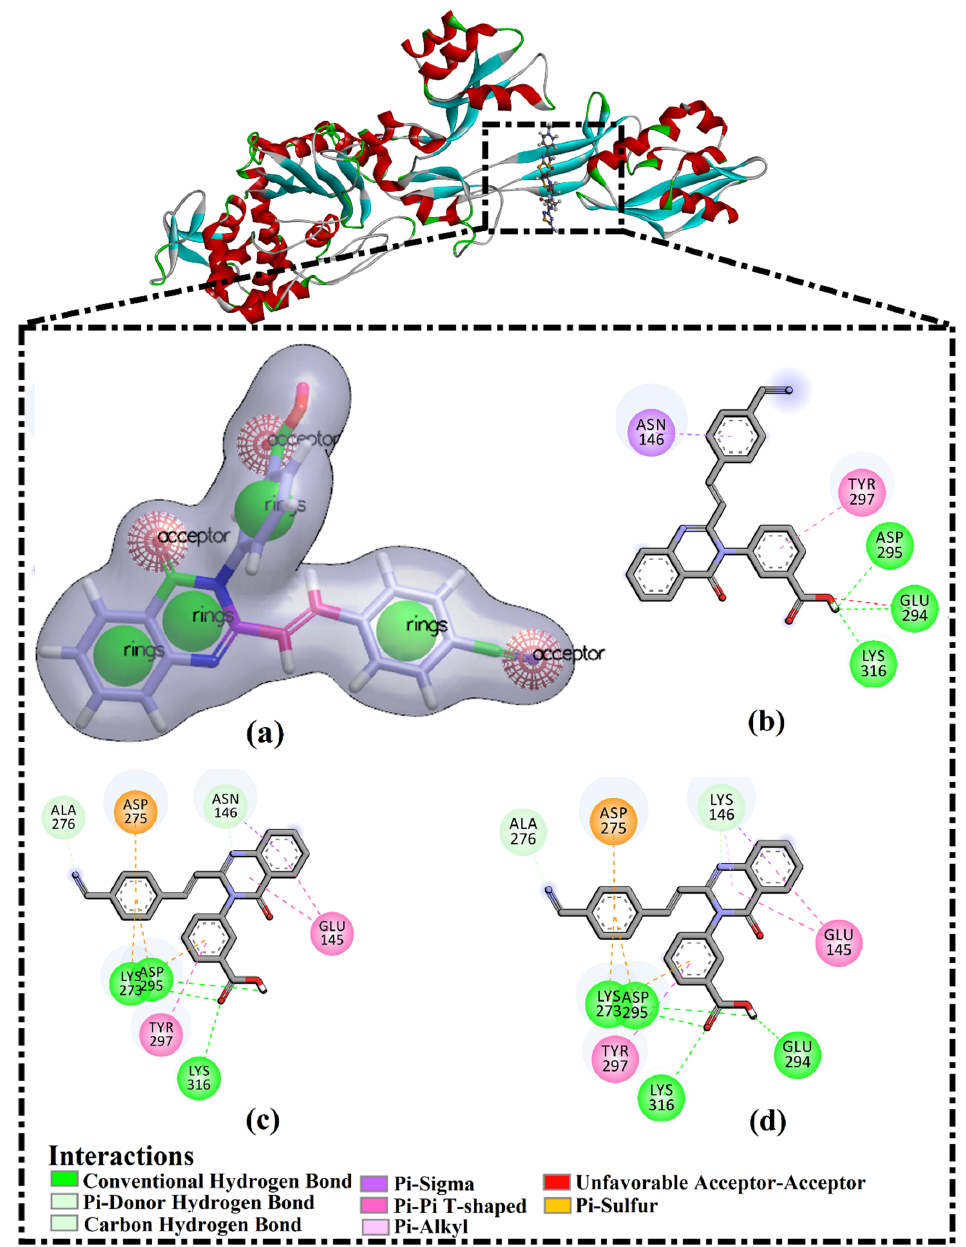
Figure 1. ( a ) 3D pharmacophore model of QNZ, ( b ) 2D representations of the experimental binding mode of QNZ with wild PBP2a allosteric site, and predicted binding modes of QNZ with ( c ) wild and ( d ) double mutated PBP2a allosteric site in acidic medium.